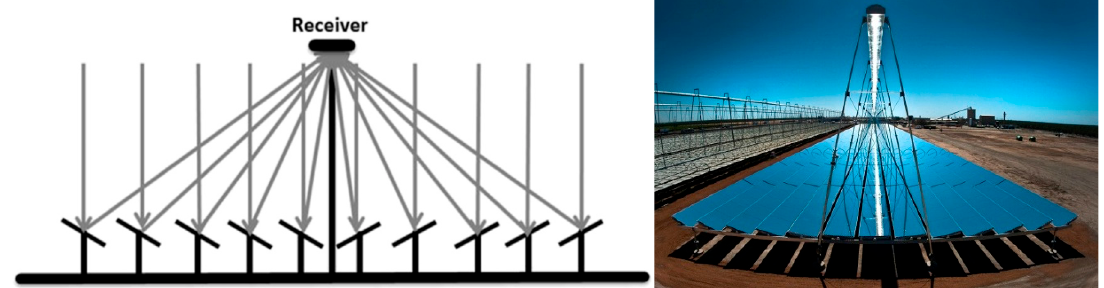
Figure 4. Schematic drawing of a Fresnel lens receiver [56].